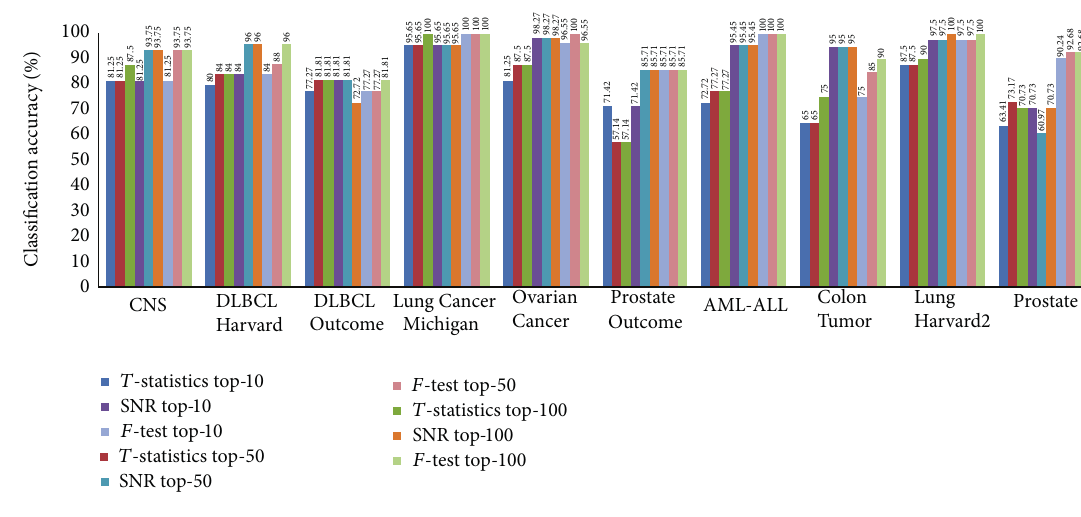
Figure 5: Classification accuracy using shuffled frog leaping. Shuffled frog leaping with levy flight